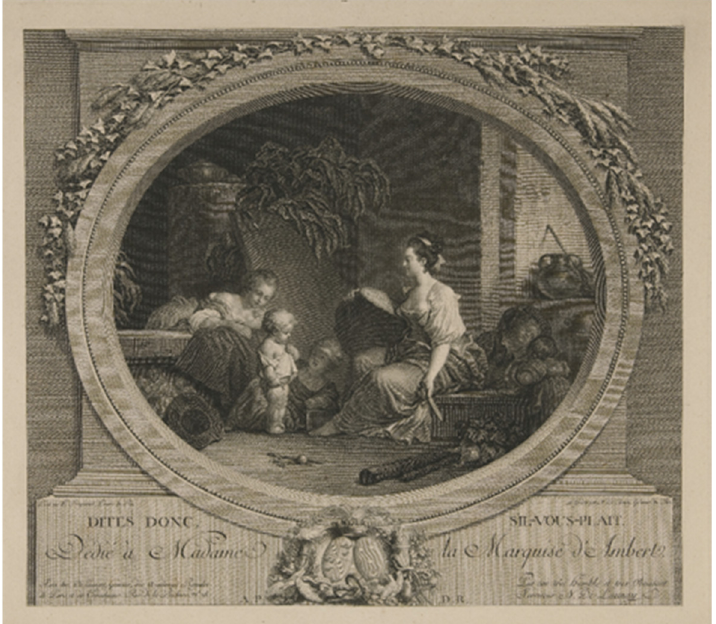
Figure 3. Nicolas de Launay after Jean Honoré Fragonard, Dites Donc, S’il-vous-plait , 1783, Etching and engraving, 27.5 cm × 31.2 cm, The British Museum, London, © The Trustees of the British Museum.